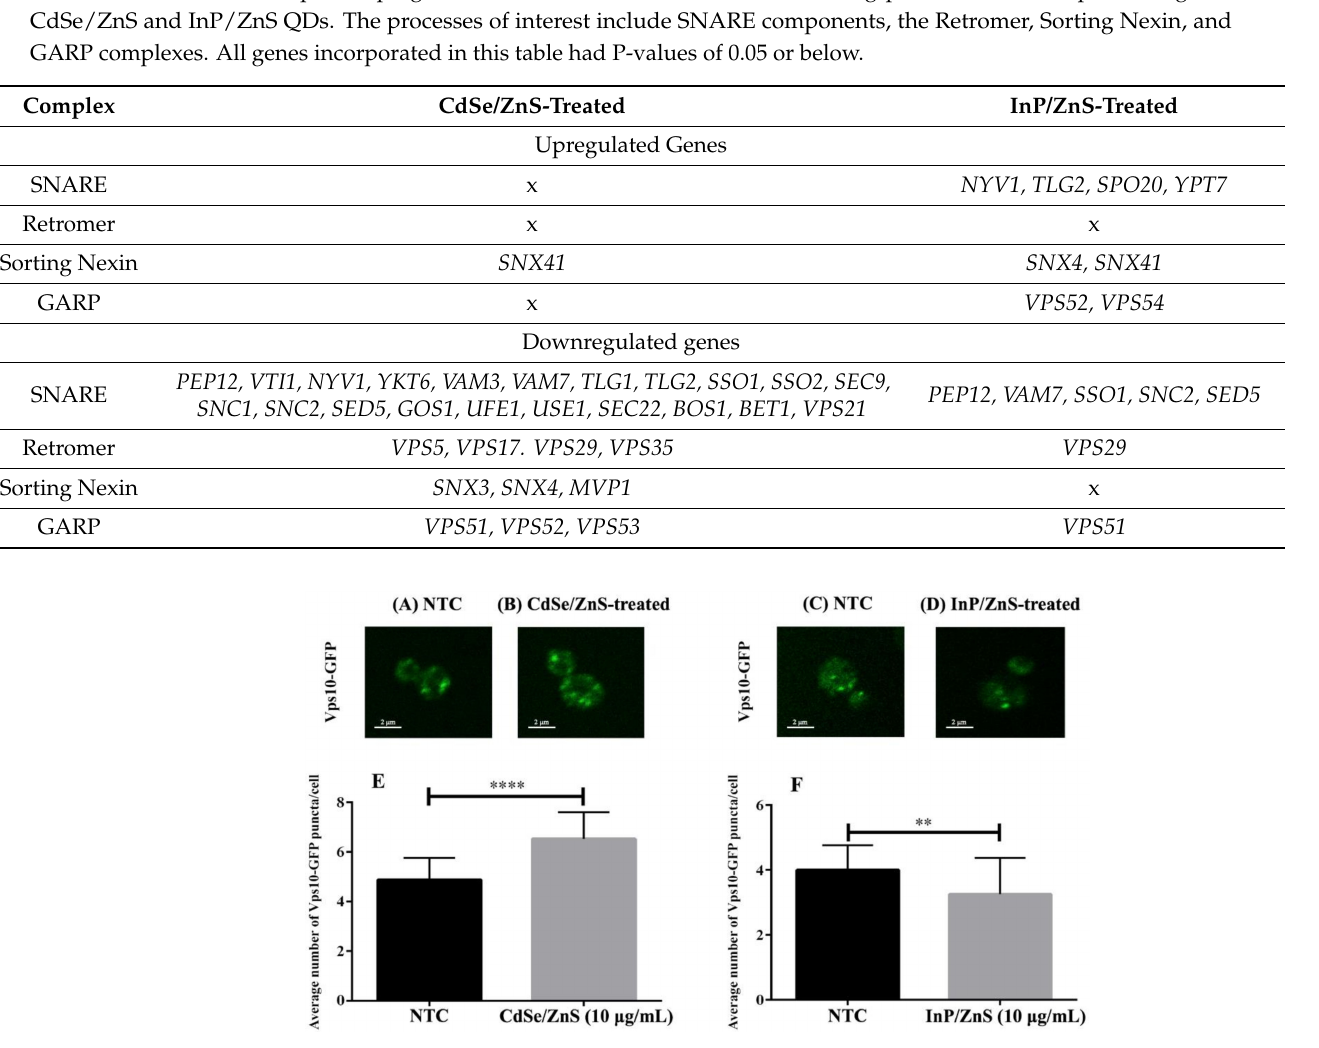
Figure 5. Cell images and bar graphs representing the number of Vps10-GFP puncta in CdSe/ZnS and InP/ZnS treated samples. ( A – D ) Representative images of wild type Vps10-GFP puncta in yeast. ( A ) Bar graph representing the average number of Vps10-GFP puncta per cell in CdSe/ZnS-treated samples. ( B ) Bar graph representing the average number of Vps10-GFP puncta per cell in InP/ZnS- treated samples. ( C ) Representative immunofluorescence image of a wild type Vps10-GFP cell